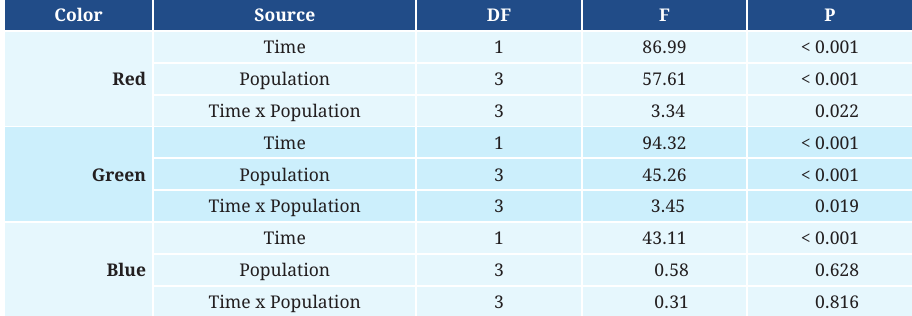
TABLE 2 | Significance values of univariate two-way tests from the MANOVA investigating differences in RGB colors among populations and during initial and final periods of the experiment. Multivariate (Pillai’s trace) statistics for the interaction term between time and population: F = 3.24; P <